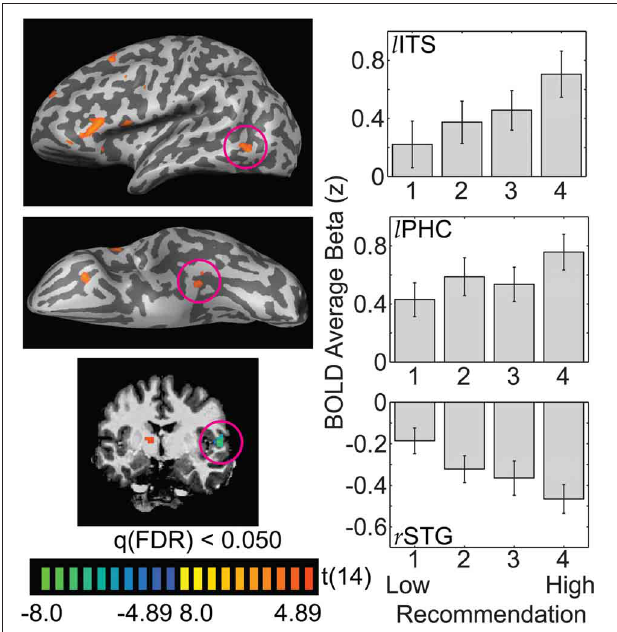
FIGURE 3 | Posterior occipito-temporal regions of cortex show linear deflections from baseline with increasing recommendation. The whole-brain images illustrate the t-statistic for the 4-vs.-1 contrast. Panels on the right illustrate the average beta weight (as a z -score) for each recommendation level, averaged across 15 observers ( l ITS = left inferotemporal sulcus; l PHC = left parahippocampal cortex; r STG = right superior temporal gyrus). Error bars are standard errors of the mean across